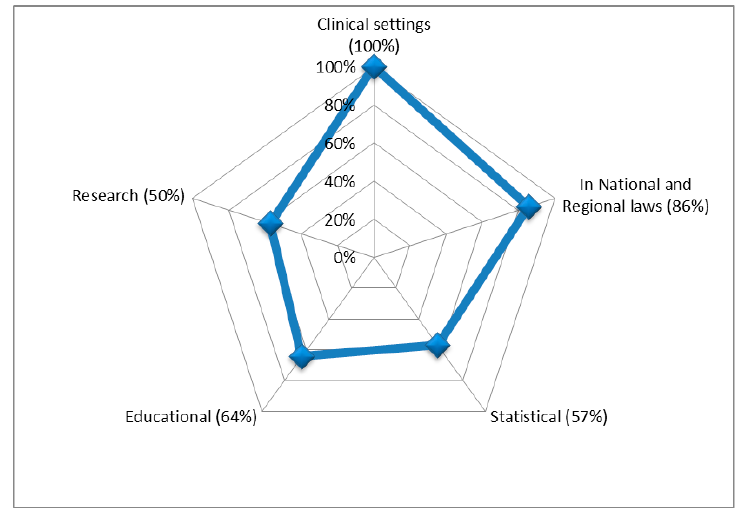
6 of 17 Figure 1. WHO Collaborating Centers that responded to the global survey. Legend: the countries reported in italics are those that did not respond to the survey (Argentina, India, Spain, Belgium, Kuwait, China, Thailand). Only 14 out of the 20 respondent countries reported the current use of the ICF in at least one area with official support: by this, either a mandatory use or a strong commit- ment by users was intended. On the contrary, the remaining 6 countries declared that ICF